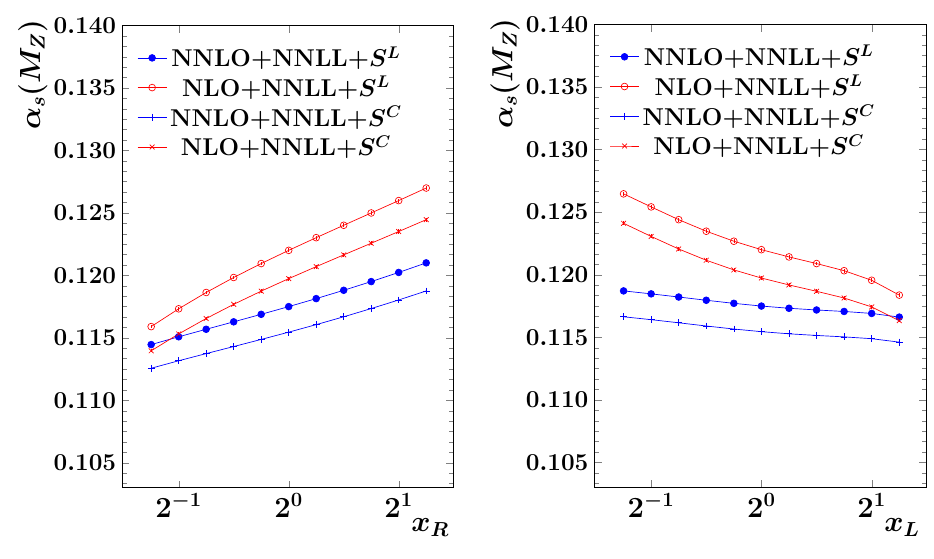
Figure 3. (left) The Figure shows as blue lines the dependence of the fit results on the value of the √ s for the default fits NNLO + NNLL with the S L and S C hadronisation renormalisation scale µ R = x R corrections, as indicated on the figure. The red lines show the results for the NLO + NNLL fits. (right) The same as (left) but for the dependence of the results on the value of the resummation scale x L